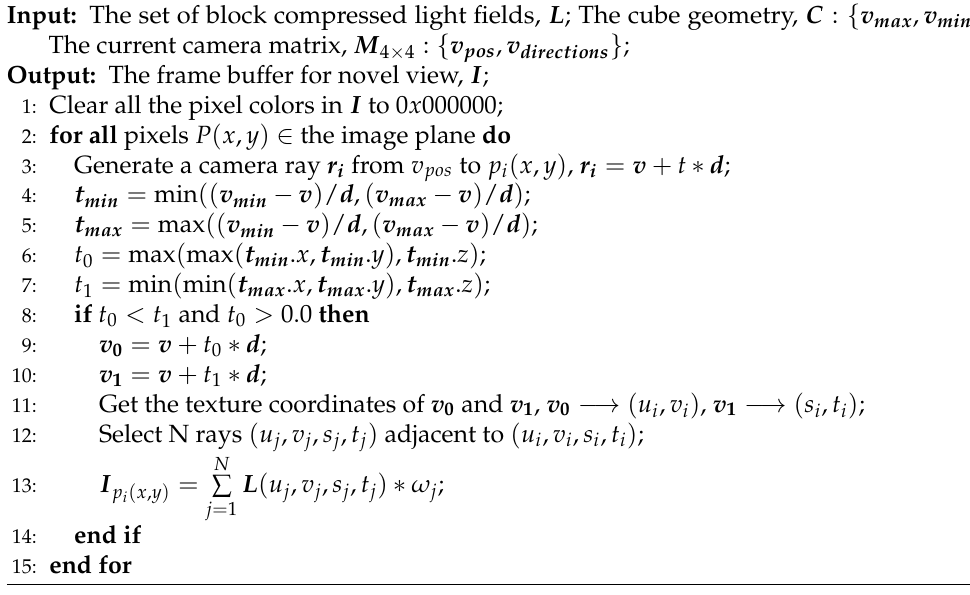
Algorithm 1 Interactive Novel View